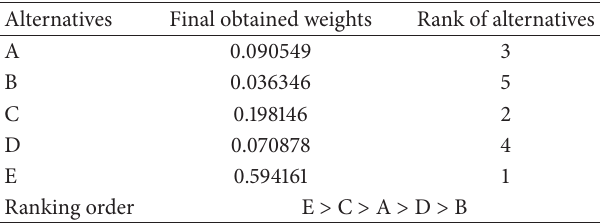
Table 20: The results of ranking aluminum waste management system